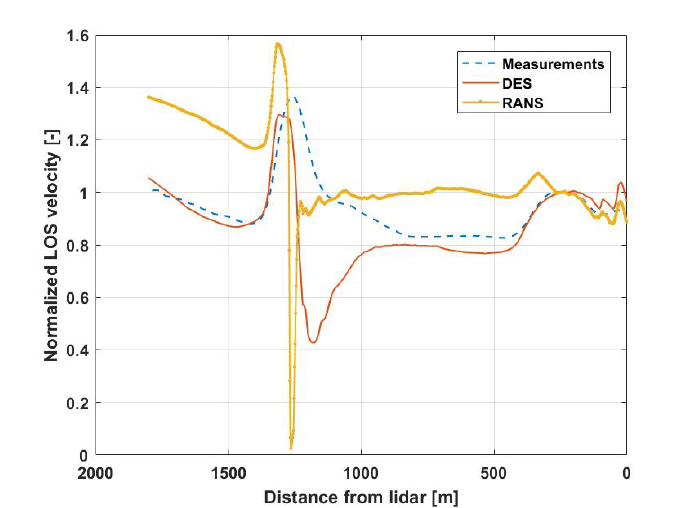
Figure 15. Velocity along the Lidar beam normalized by the upstream free flow velocity averaged for 14 June 2015 1:00 p.m. to 10:30 p.m. measured by the Lidar and computed with the Reynolds-Averaged Navier-Stokes (RANS) and Detached Eddy Simulation (DES)